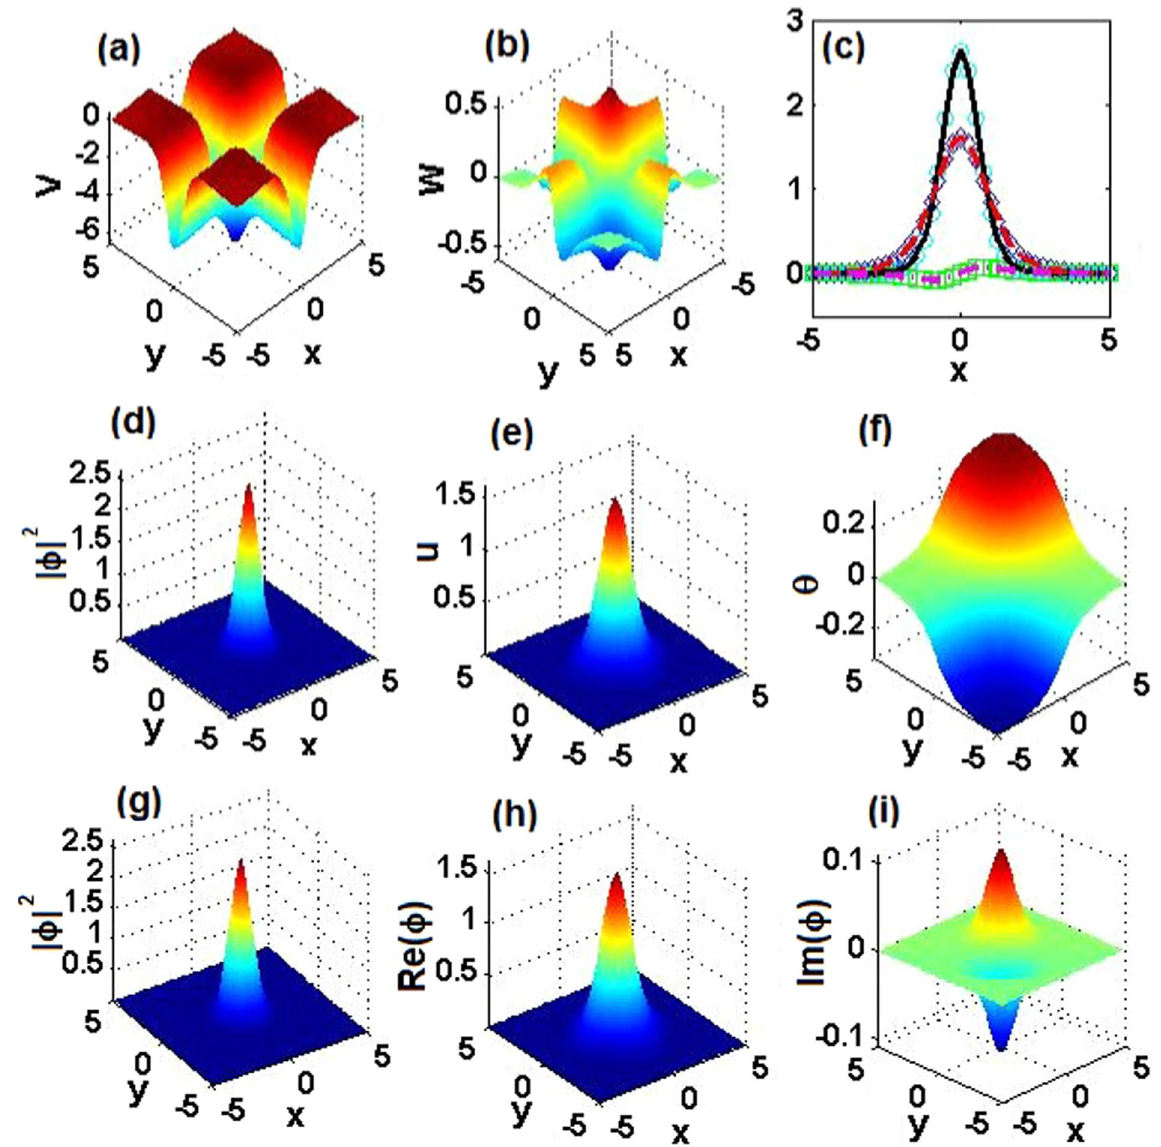
Figure 9. 2D PT -symmetric solitons for α = 1. ( a ) Real and ( b ) imaginary parts of the 2D PT -symmetric complex potentials given by Eq. (24a). ( c ) Comparison of real parts, imaginary parts, and intensity of exact soliton solution φ x ( , 0) and numerically found fundamental soliton φ x ( , 0) at μ = 9/2, cf. Fig. 2(a1) pertaining e n to the 1D setting. ( d ) The intensity, ( e ) amplitude, and ( f ) phase of the exact soliton. ( g ) The intensity, ( h ) real part, and ( i ) imaginary part of the numerically found fundamental soliton. Parameters are θ = . . m ( , ) (0 5, 0 1) 0 0